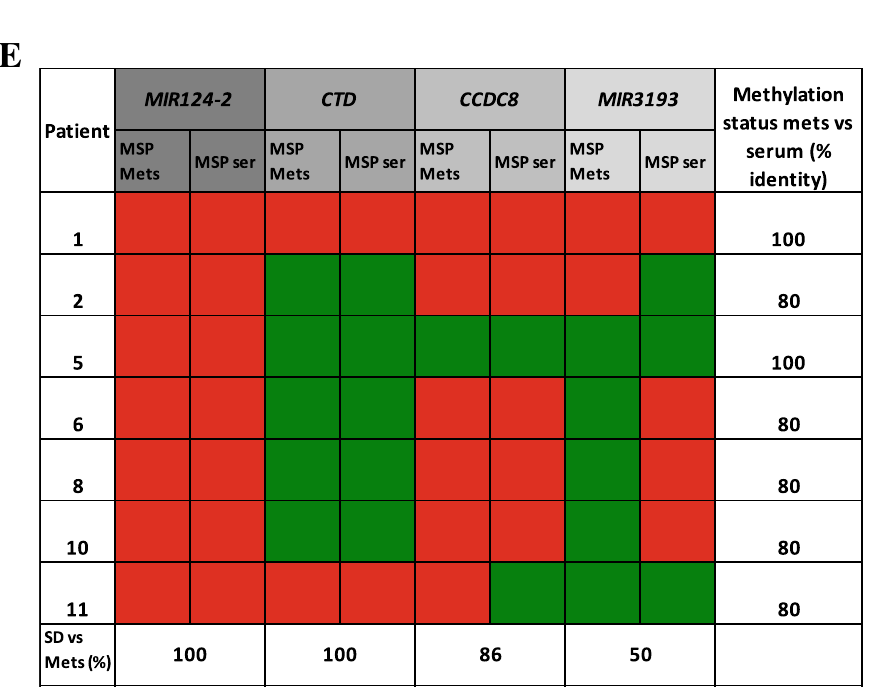
Figure 4. Methylation status of candidate genes in BBM, and tumour free circulationg DNA (tfcDNA) in patients’ serum determined by Methylation Specific PCR (MSP). ( A,B ) Methylation status of candidate genes denoting early events ( CCDC8 and MIR124-2 ) and ( C,D ) late events ( CTD-2023M8 and MIR3193 ) in BBM and their corresponding tumour free circulating DNA in individual patients (presence of a PCR product in the MSP lane is indicative of methylation in the region analysed). ( E ) Summary of methylation status of BBM and serum DNA in individual patients; Red suqares indicate methylation identified, Green squares indicate no methylation identified. BBM: Brain Metastases, SD: Serum DNA, U: Unmethylation Specific PCR; USP, M: Methylation Specific PCR; MSP, *: Methylated